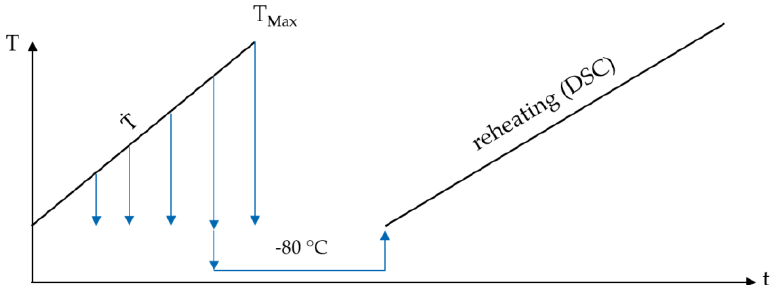
Figure 2. Schematic time-temperature profile of the heat treatments for the indirect measurements.